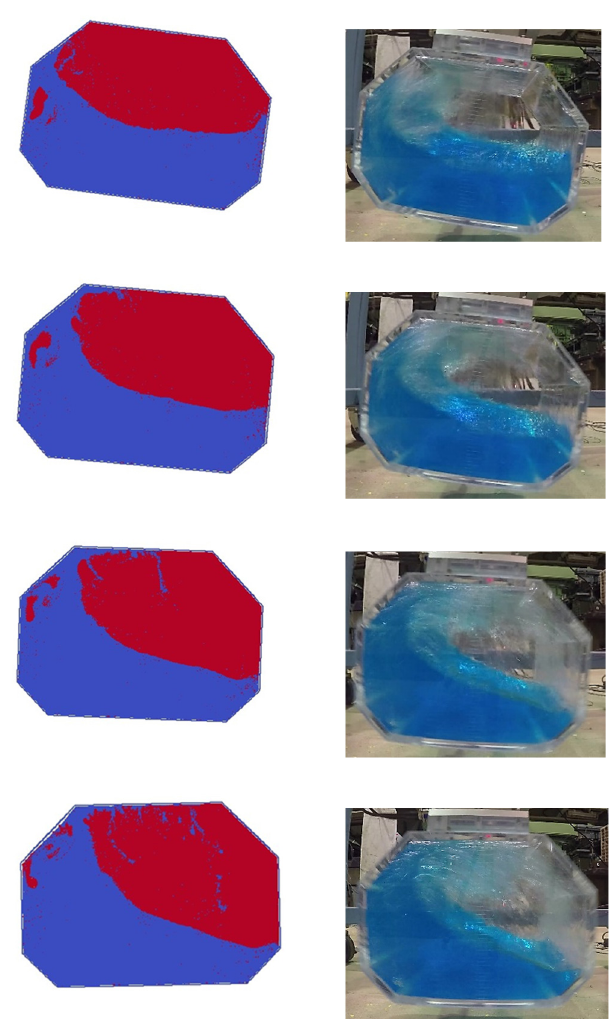
Figure 18. Images of air-water mixture under roll oscillation with a filling ratio of 50% at t = 16.15 seconds, 16.20 seconds, 16.25 seconds, and 16.30